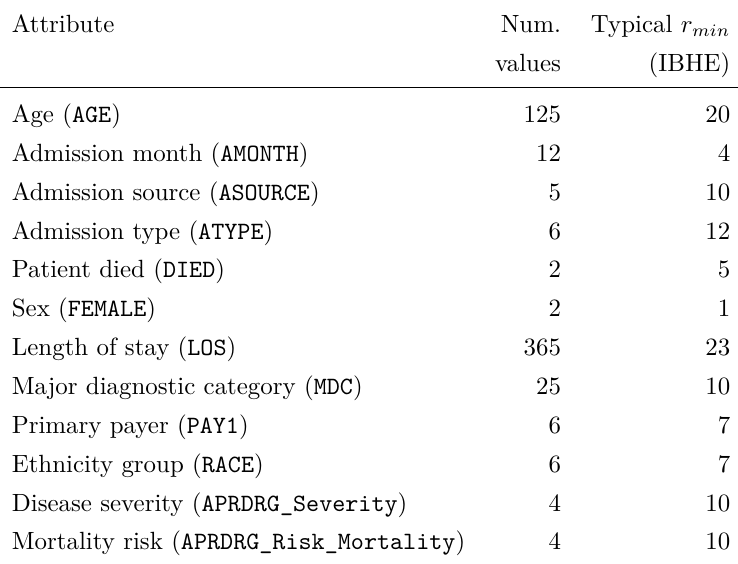
Table 2: The 12 attributes targeted in our